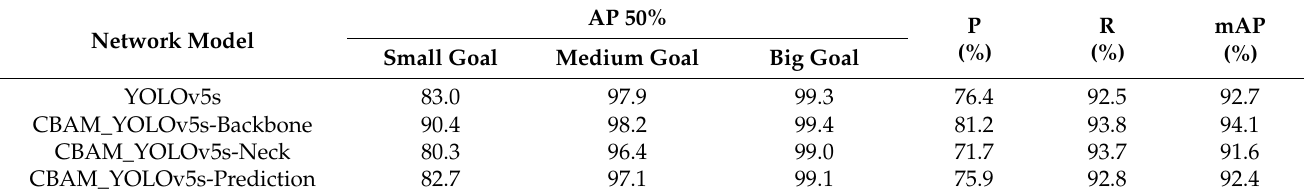
Table 2. Comparison of CBAM modules after fusion.